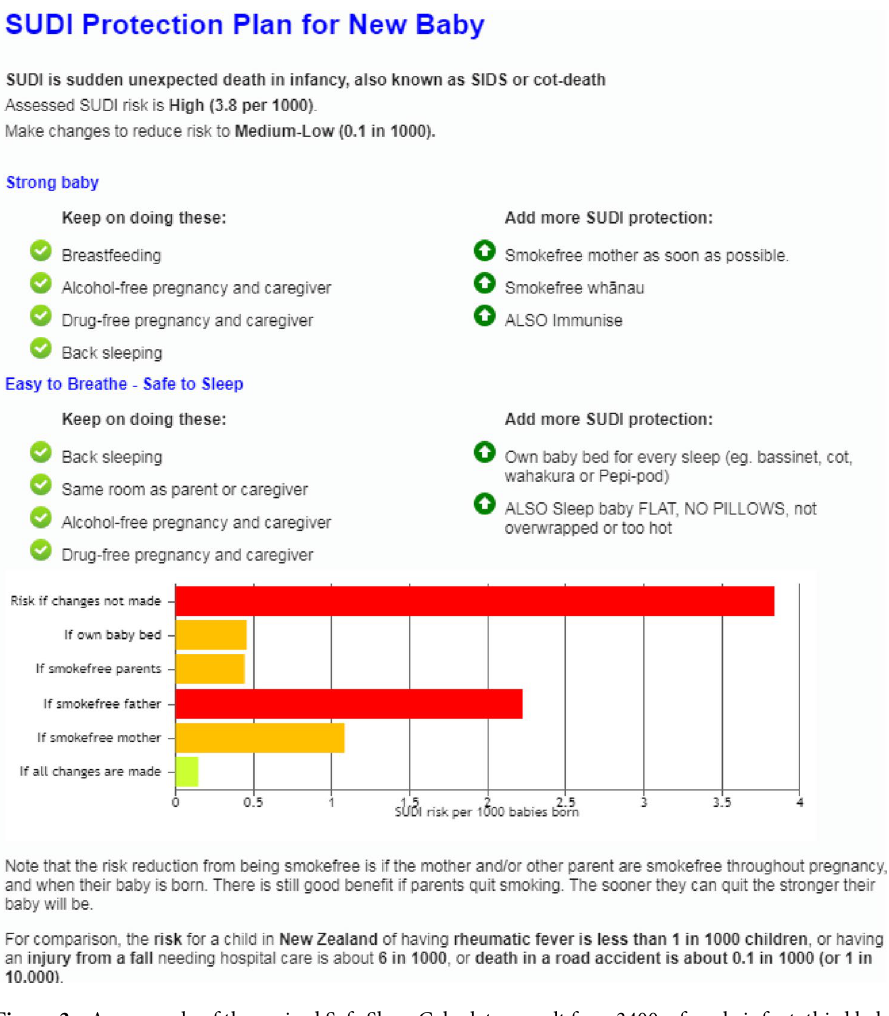
Figure 3. An example of the revised Safe Sleep Calculator result for a 3400 g female infant, third baby, mother and father smoke, mother does not drink alcohol or use drugs and her baby sleeps on her back and bedshares with her